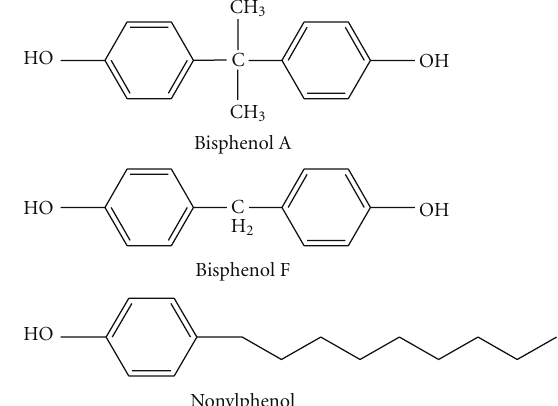
(cid:0) passed through solution,